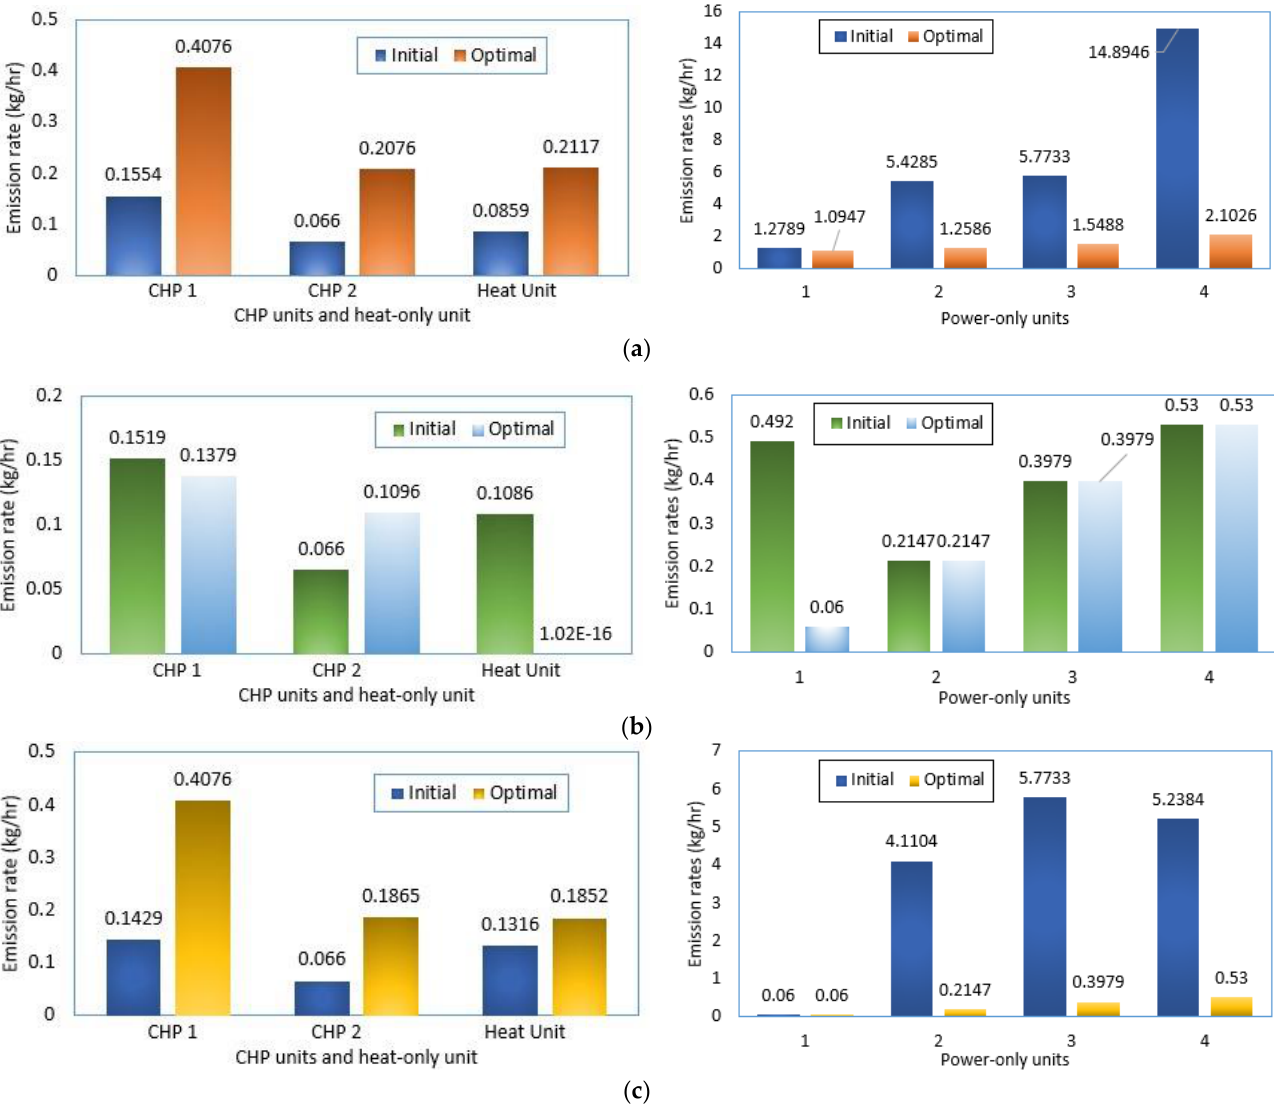
Table 9. Results of the proposed HBOA of Case 4 for the three loading levels. Units